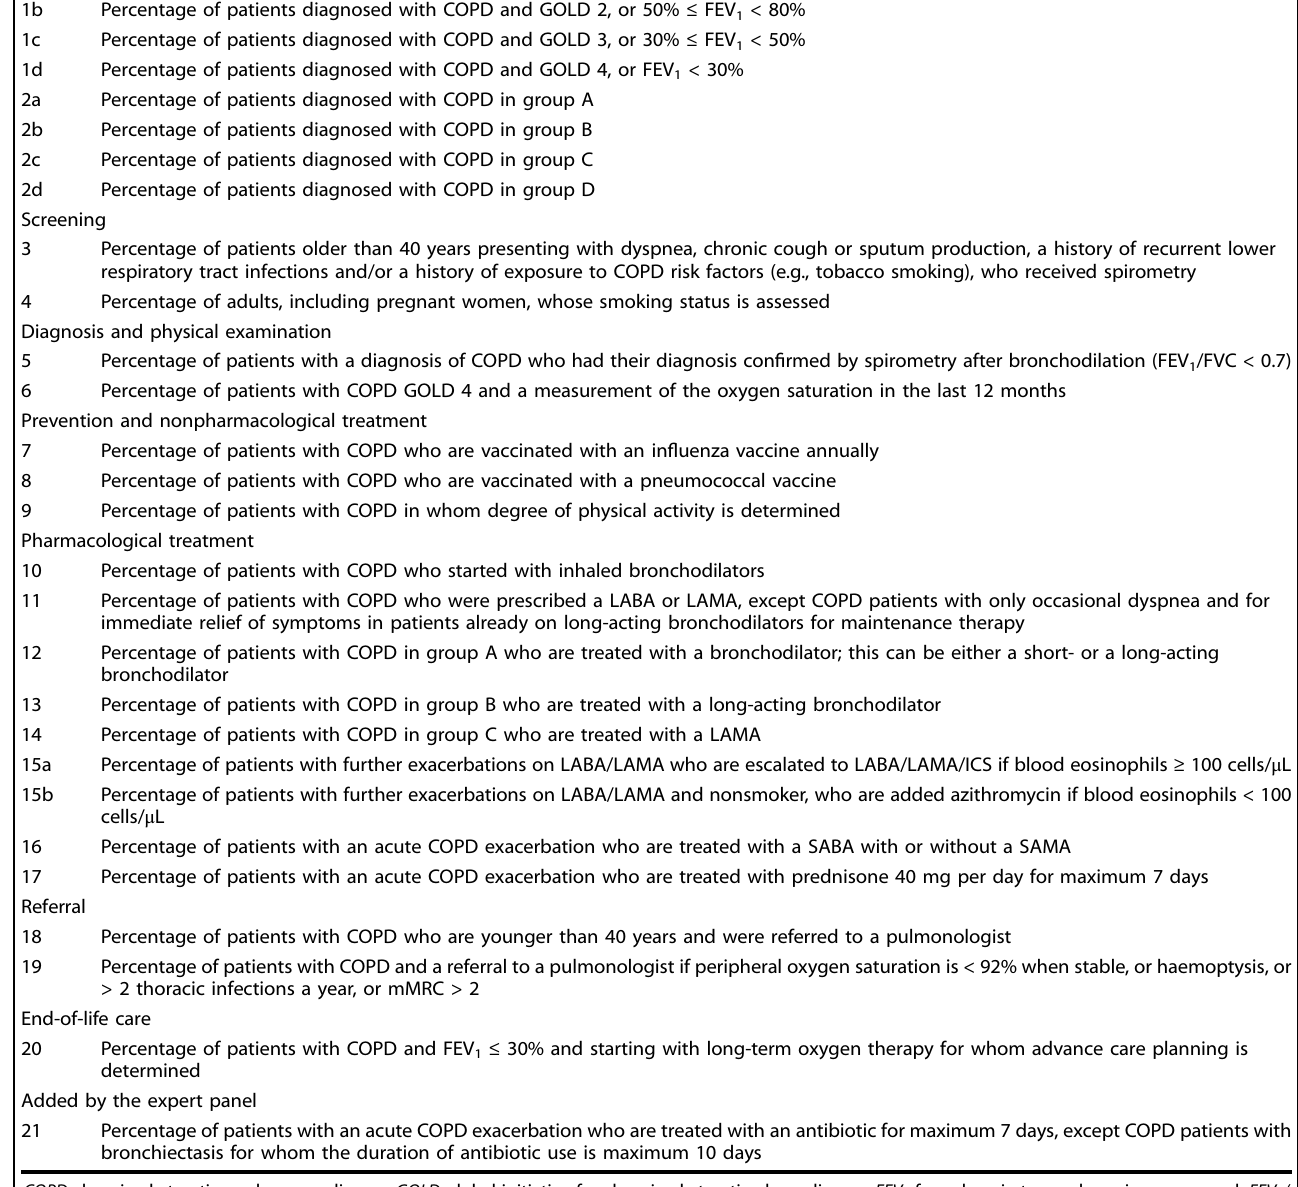
Percentage of patients with an acute COPD exacerbation who are treated with an antibiotic for maximum 7 days, except COPD patients with bronchiectasis for whom the duration of antibiotic use is maximum 10 days COPD chronic obstructive pulmonary disease, GOLD global initiative for chronic obstructive lung disease, FEV 1 forced expiratory volume in one second, FEV 1 / FVC forced expiratory volume in one second/forced vital capacity, LABA long-acting beta 2 -agonist, LAMA long-acting muscarinic antagonist, ICS inhaled corticosteroids, SABA short-acting beta 2 -agonist, SAMA short-acting muscarinic antagonist, mMRC modi fi ed Medical Research Council dyspnea